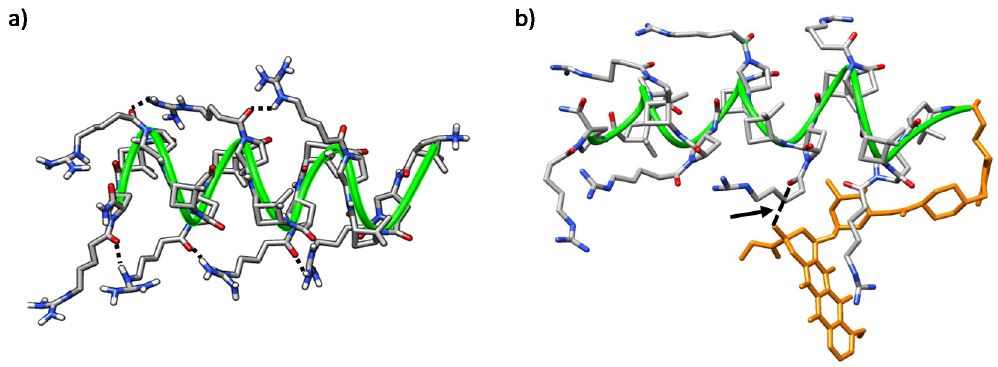
Figure 11. Representative MD conformations for ( a ) peptide γ -CT 9 , inter-residue interactions are marked; and ( b ) conjugate ( R )-Dox- γ -CT, ( R )- 16 . The peptide scaffold is highlighted by the green ribbon; Dox is represented in orange; the arrow points out long-range hydrogen-bonding between the tertiary hydroxyl group of the cyclohexane ring in the Dox-moiety and the N α -side chain C O in proline residue i = 6.